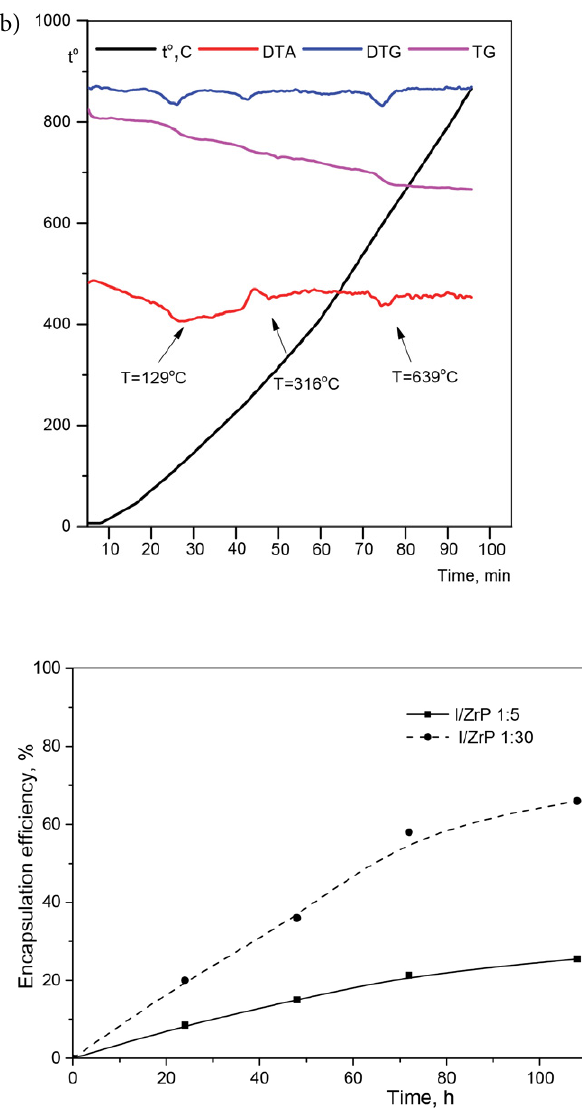
Fig. 10 Time-dependent I encapsulation efficiency of ZrP nano-